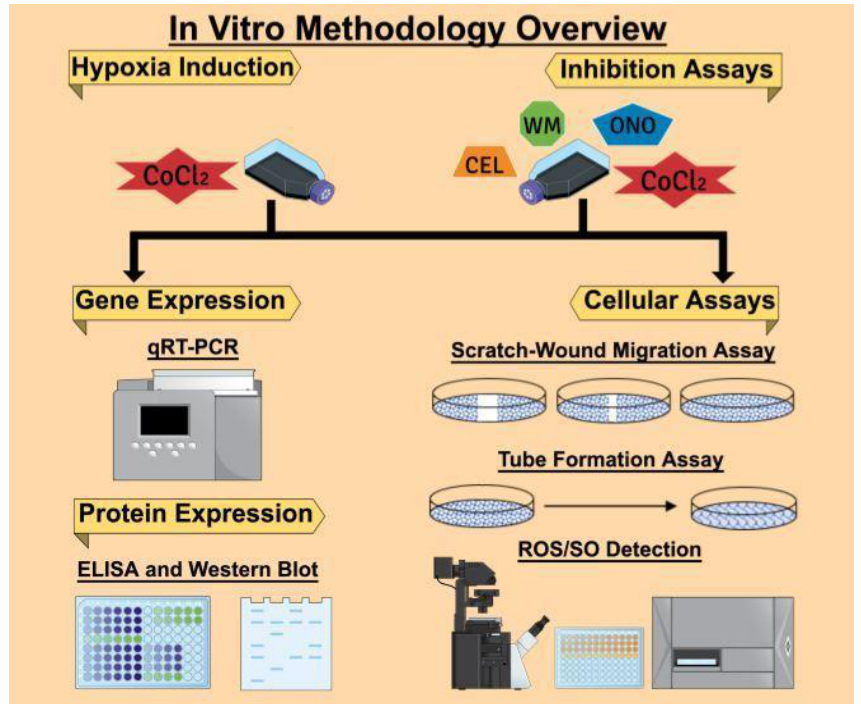
Figure 13. In vitro methodologies overview.